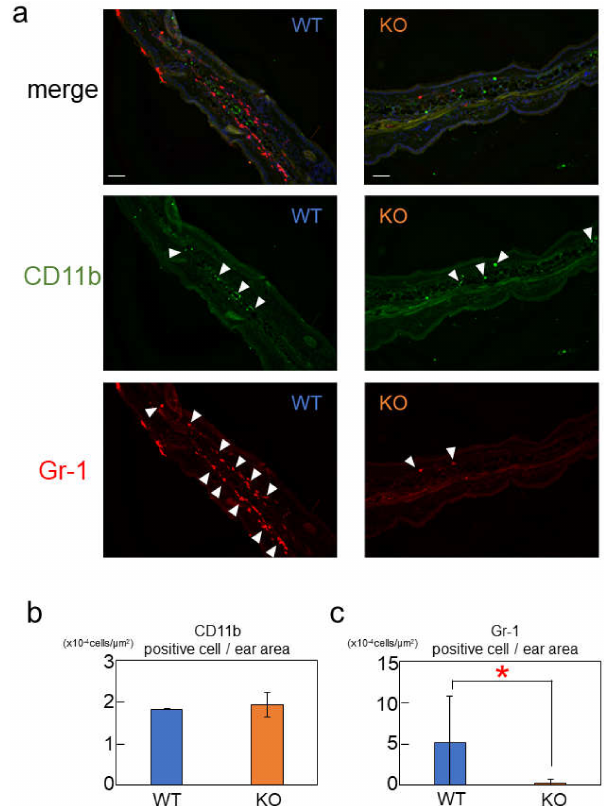
Figure 6. Immunofluorescence analysis of CD11b and Gr-1-positive cells in nickel-induced ear in wild-type (WT) and Rab44-knockout (KO) mice. ( a ) The fixed sections of the nickel-treated ear were blocked with 1.0% bovine serum albumin in PBS. The samples were incubated with rabbit anti-CD11b IgG (1:400) and rat anti-Gr-1 IgG (1:200), as the primary antibody, followed by fluorescent labelling with Alexa Fluor 488-conjugated anti-rabbit IgG and Alexa Fluor 555-conjugated anti-rat IgG, and then observed by microscopy. Bars: 50 µ m. White arrowheads indicate the antibody reactive cells. ( b , c ) Quantitative analysis of CD11b and Gr-1-positive cells per µ m 2 after visualization by microscopy. Data are represented as the mean ± S.E. of values from three independent experiments. Asterisks indicate statistical significance compared to the control; * p <